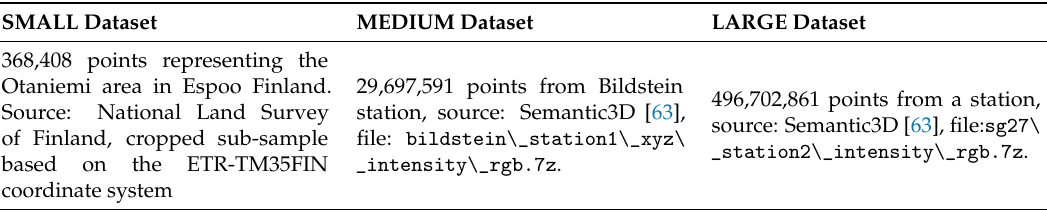
Figure 3. A point cloud visualization for the LARGE dataset from Semantic3D [63] representing a station. File: http://semantic3d.net/data/point-clouds/training1/sg27_station2_intensity_rgb.7z. Table 1. The three datasets that were used, of which the MEDIUM and LARGE are from Semantic3D.net